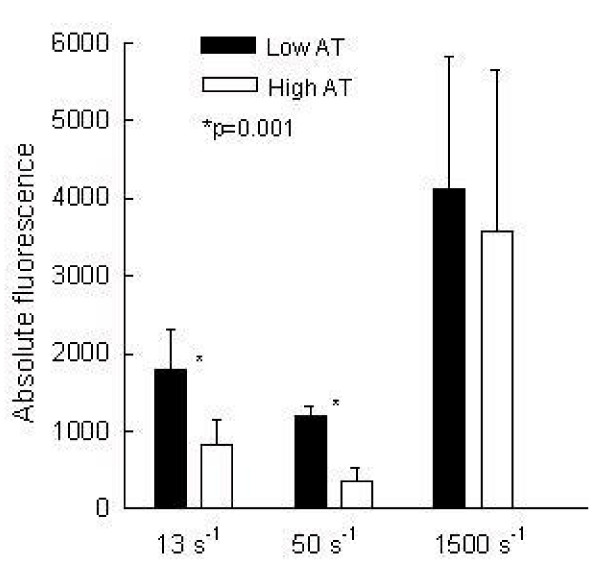
Platelet adhesion under different shear rates was selected according to the plasma antithromin activity of respected samples. Low activity = plasma AT activity <95% (n = 7) and high activity = plasma AT activity >105% (n = 13). Statistically significant difference in platelet adhesion with regard to the low and high AT activity was observed at 13 s-1 and 50 s-1 (p < 0.05). Similar trend was observed under arterial flow conditions but without statistical significance.